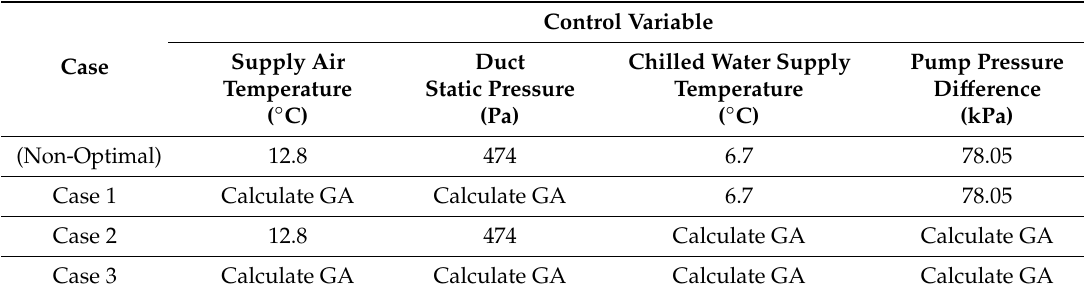
Table 3. Optimal control